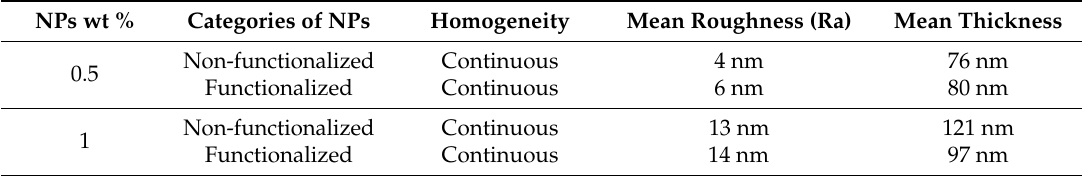
Figure 5. 5 × 5 µm AFM micrographs showing the morphology of the composite PVDF thin film on silicon substrate with different concentrations of NPs ( a ) 0.5 wt % of non-functionalized NPs; ( b ) 0.5 wt % of functionalized NPs; ( c ) 1 wt % of non-functionalized NPs; and ( d ) 1 wt % of functionalized NPs. Table 3. Morphology characteristics of the composite PVDF thin films as function of the NPs concentration and their functionalization